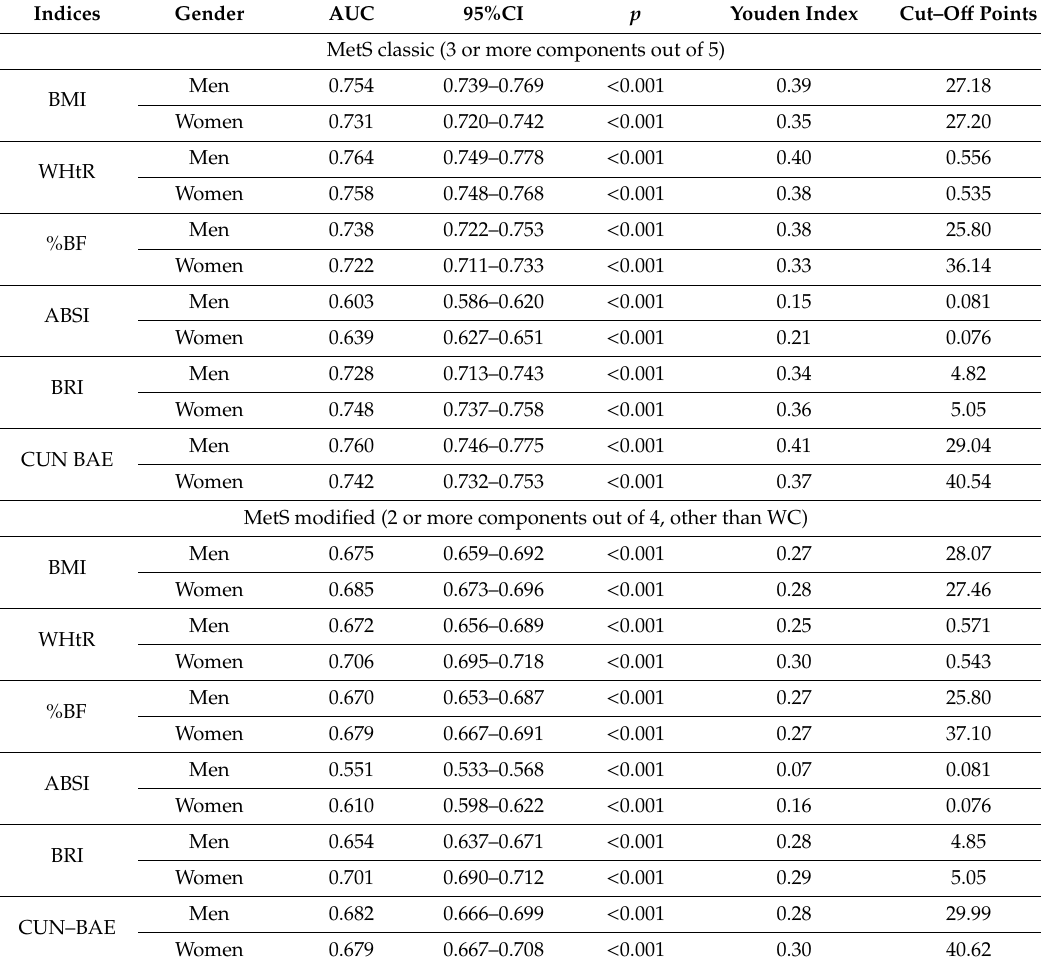
Table 5. The AUCs of each anthropometric index for the presence of MetS in both